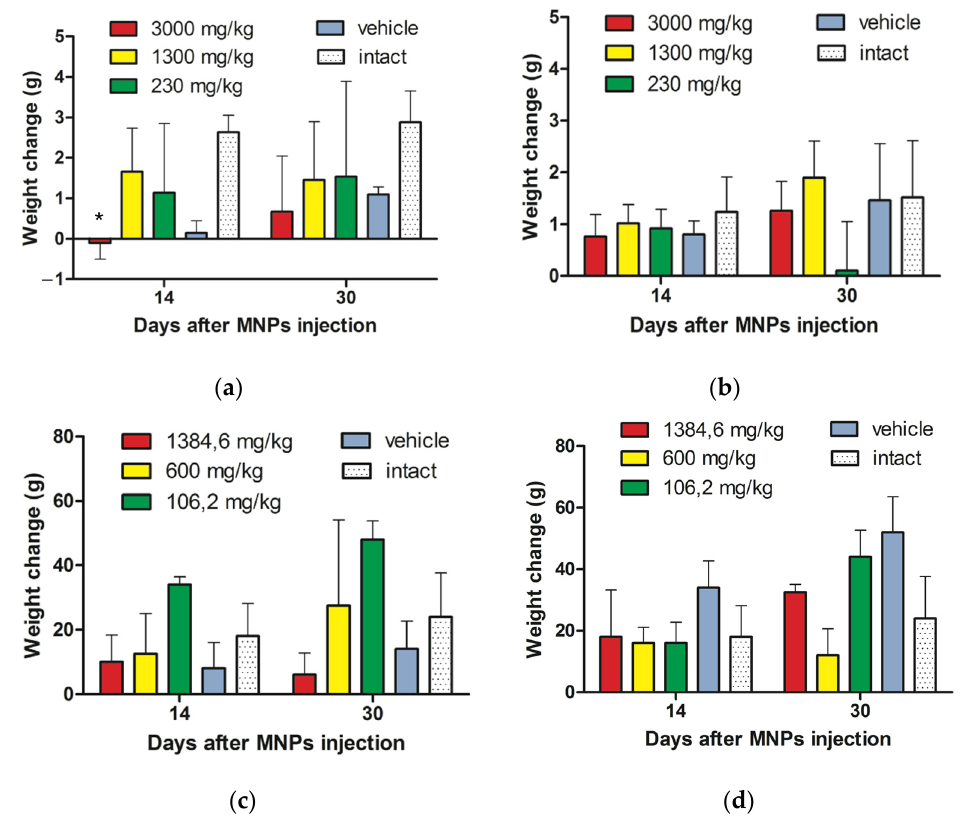
Figure 2. Animals weight change in the study of cobalt ferrite MNPs acute toxicity after i.p. injection. ( a ) Normalized body weight comparison between male mice from five experimental groups; ( b ) Normalized body weight comparison between female mice from different experimental groups; ( c ) Normalized body weight comparison between male rats from experimental groups; ( d ) Normalized body weight comparison between female rats from experimental groups. Results are shown as means ± SEM. * p < 0.05 (unpaired t -test).